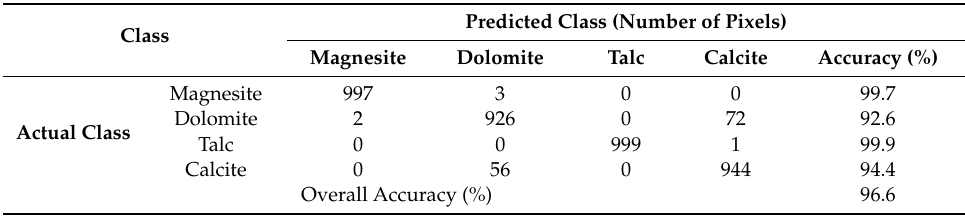
Table 11. A confusion matrix for the classification results of the validation set from the random forest